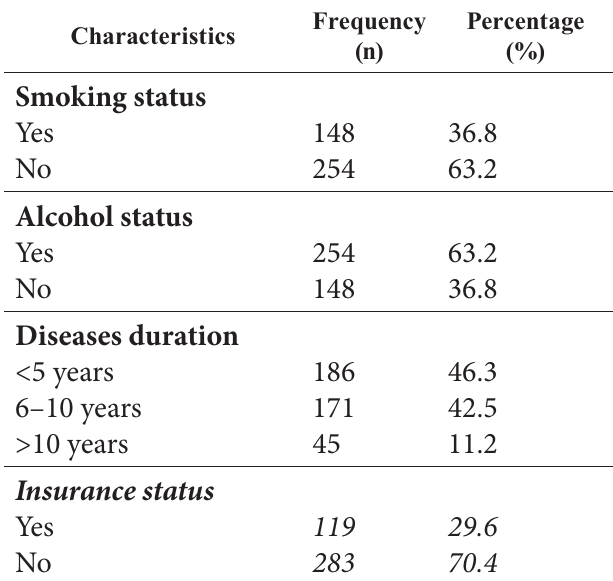
TABLE I - S ummary of the demographics of respondents (n =